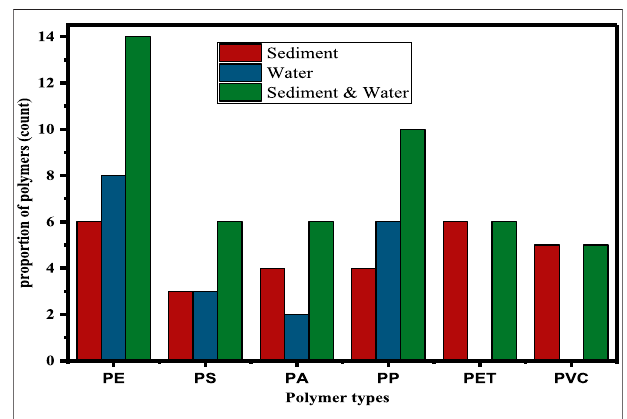
FIGURE 6 | Identi fi ed MPs polymeric proportion in sediment and water sample, and total